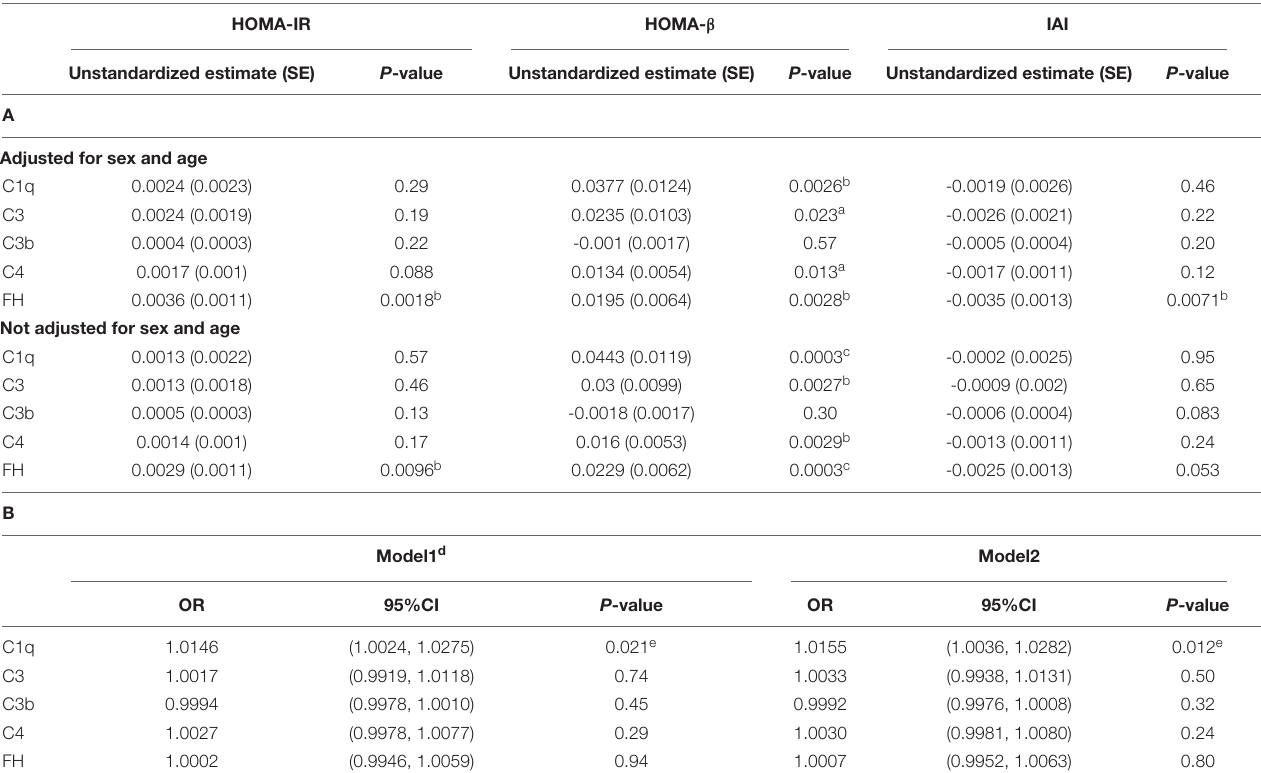
TABLE 3 | Associations of insulin resistance or cognitive function with complement proteins. (A) Linear regression analysis assessing complement proteins associated with insulin resistance and β -cell function. (B) Logistic regression analysis assessing complement proteins associated with cognitive impairment. HOMA-IR HOMA- β